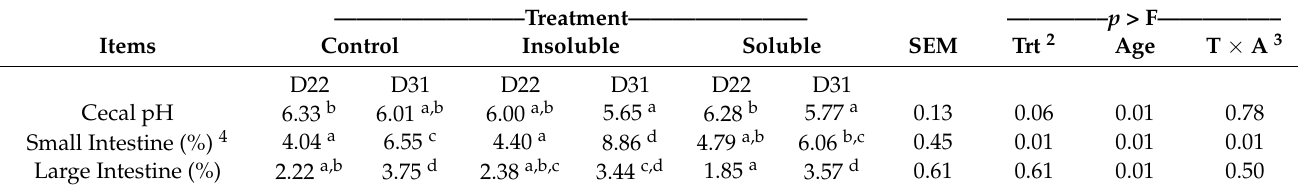
Table 3. Intestinal characteristics in piglets fed insoluble or soluble gruel creep diets, measured before (D22) and after weaning (D31), compared with non-creep-fed controls 1 .